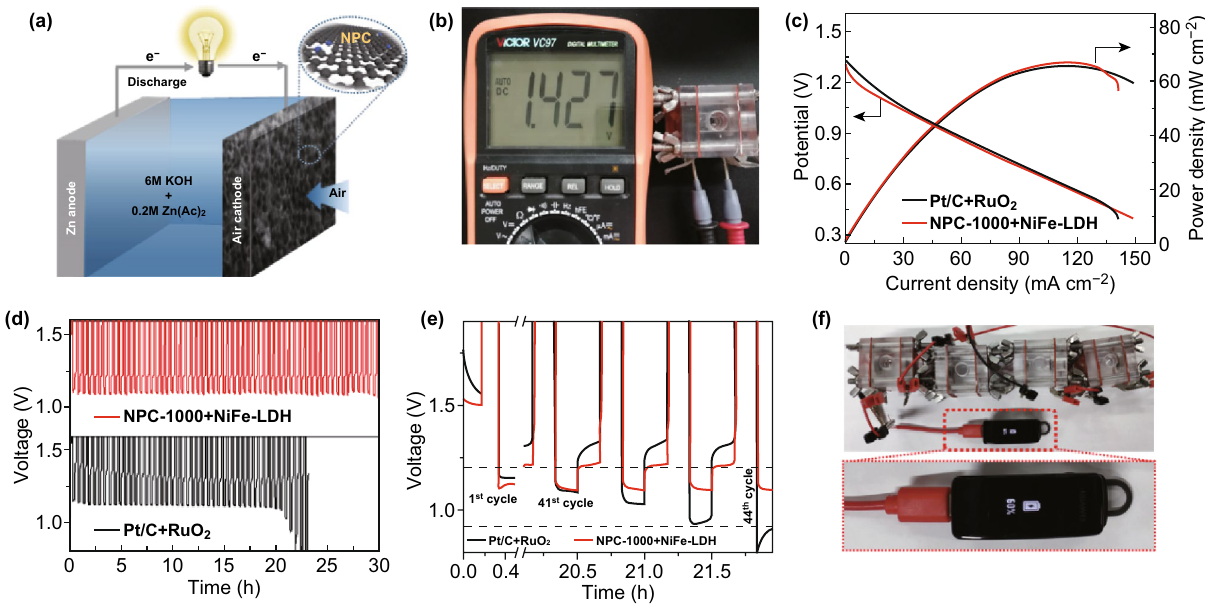
Fig. 5 a Schematic illustration of the Zn–air battery with NPC-1000 as the air cathode, b image of the ZAB with a measured open-circuit volt- age of 1.43 V, c discharge polarization curves and corresponding power-density plots, d , e charge/discharge cycling at 10 mA cm −2 (0.5 h for each cycle) for a rechargeable ZAB with NPC-1000 and NiFe-LDH as the air cathode, f image of a Bluetooth headset powered by four ZABs in